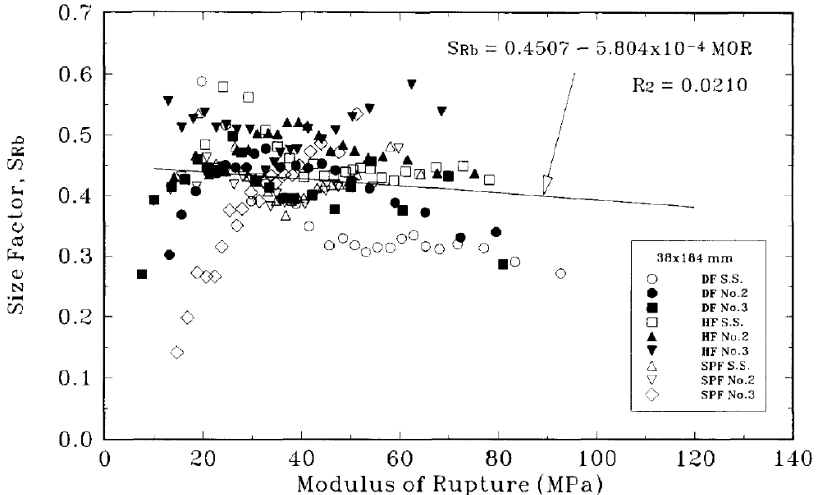
Figure 26. Plot showing the variation of bending size parameter S Rb with modulus of rupture. From [154].